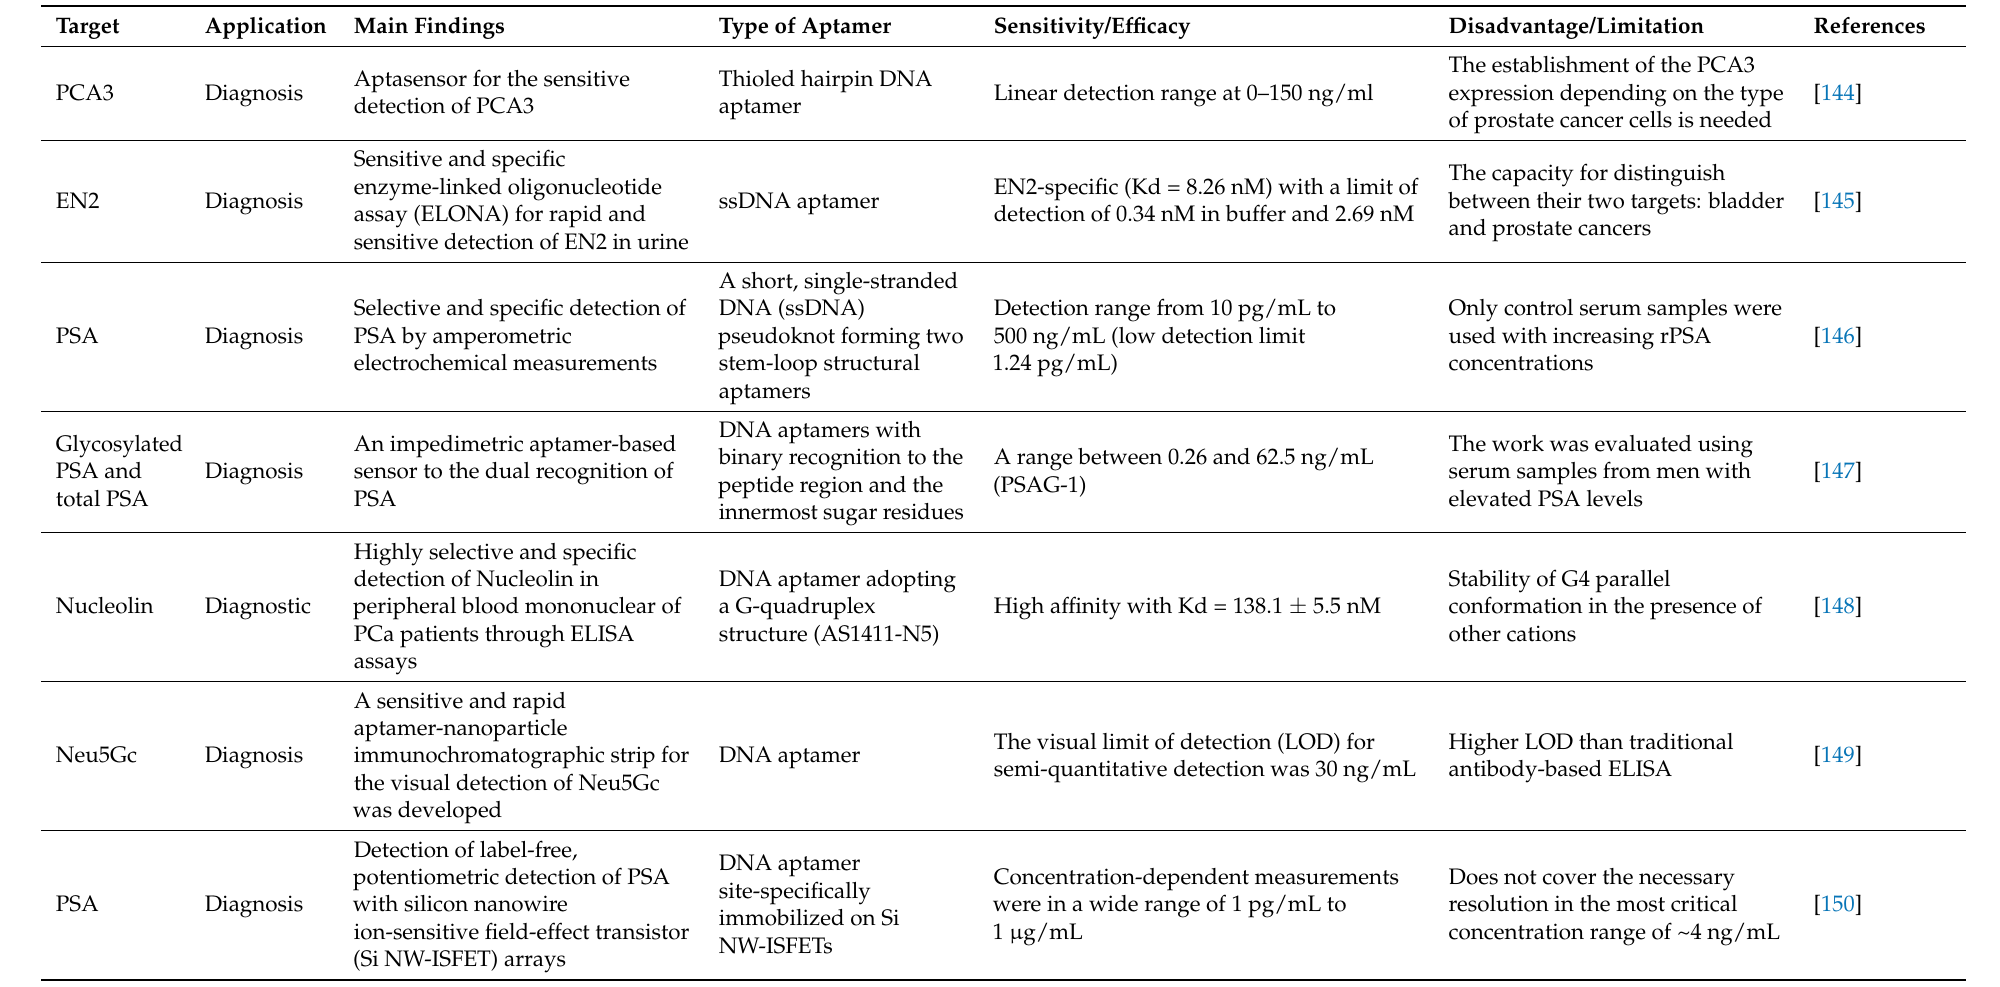
Table 5. Aptamers in PCa